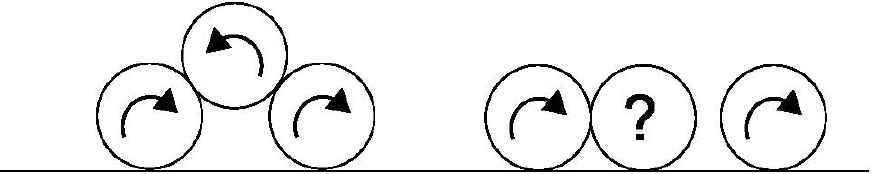
Figure 7. Schematization of the frustration in the rotations of the particles in the first layers of the flow.